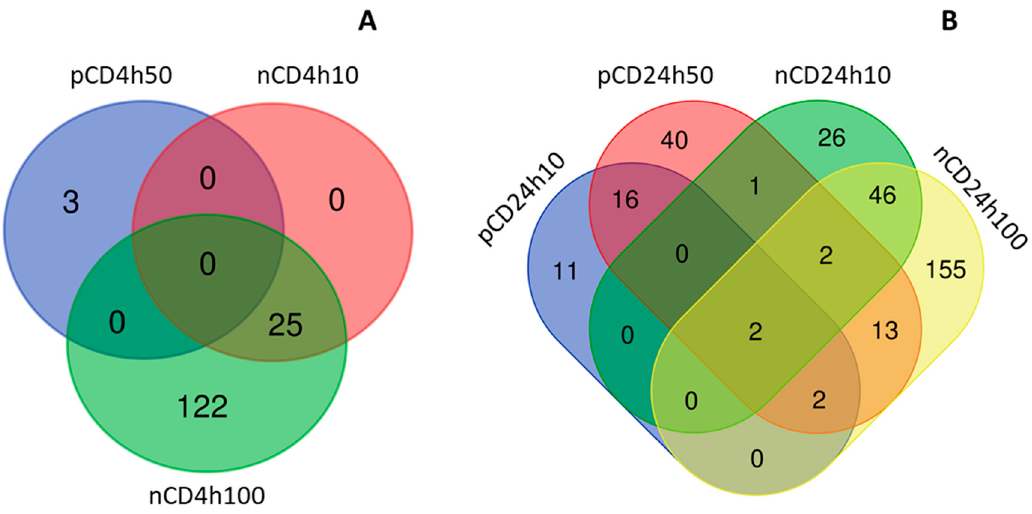
Figure 11. The numbers of common and unique miRNAs deregulated after CD NPs exposure; a comparison between CDs for individual doses ( A ) and exposure times ( B ).